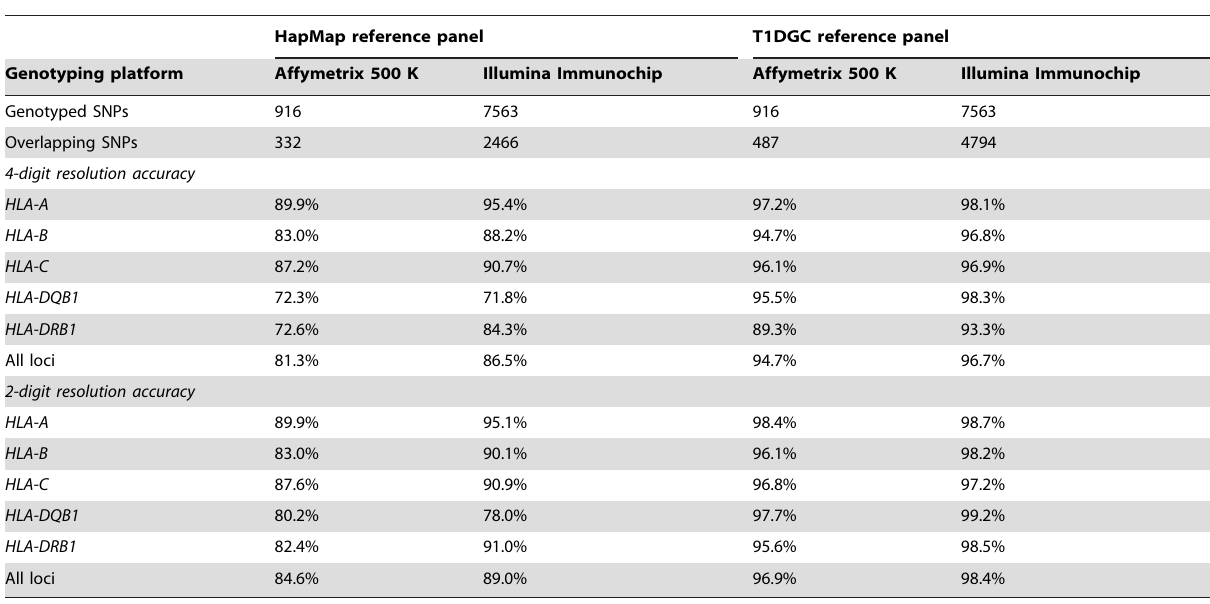
Table 2. Imputation accuracy measured as the genotype concordance for two- and four-digit classical HLA alleles measured in the British 1958 Birth Cohort (B58BC, 918 individuals) as a function of reference panel (HapMap or T1DGC) and genotyping platform (in